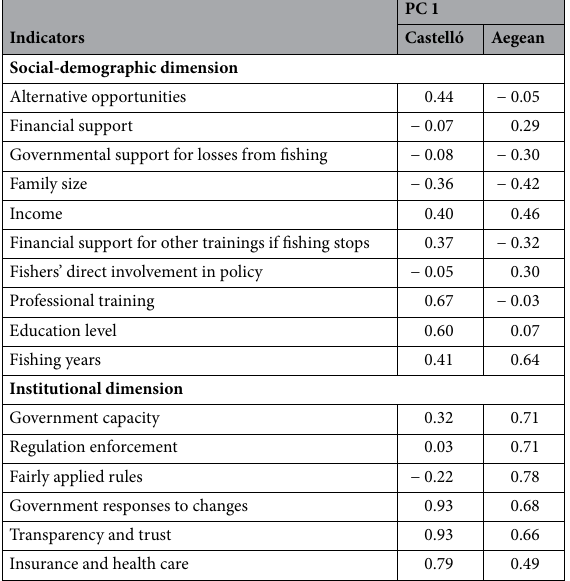
Table 5. Component matrix for the adaptive capacity indicators from PCA